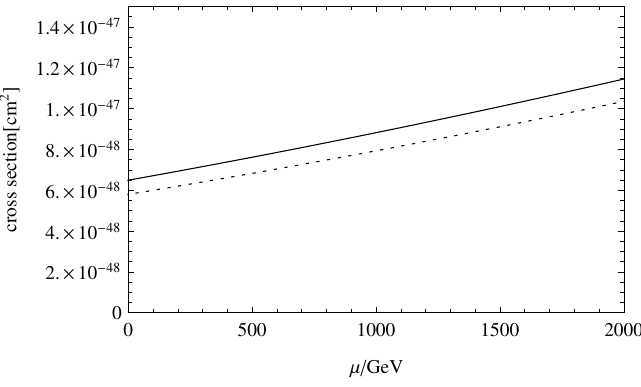
^ (cid:17); ^(cid:22) (cid:17); ^ S are added to the MSSM. Through the seesaw mechanism, three tiny